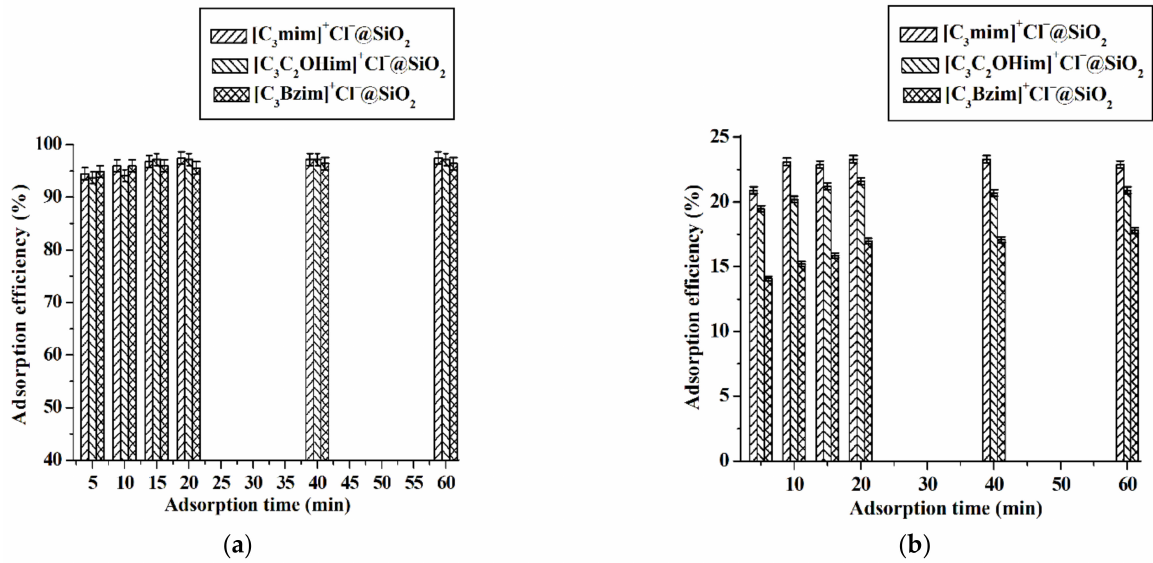
Figure 8. Adsorptionefficiencyof[C 3 mim] + Cl − @SiO 2 ,[C 3 C 2 OHim] + Cl − @SiO 2 and[C 3 Bzim] + Cl − @SiO 2 . ( a )C baicalin =5.0 × 10 − 5 mol · L − 1 and ( b ) C baicalin = 9.0 × 10 − 3 mol · L − 1 . Experimental conditions: adsorbent, 40 mg; volume of baicalin aqueous solution, 10 mL; pH 5.0; adsorption temperature, 25 ◦ C. Experiments were conducted in